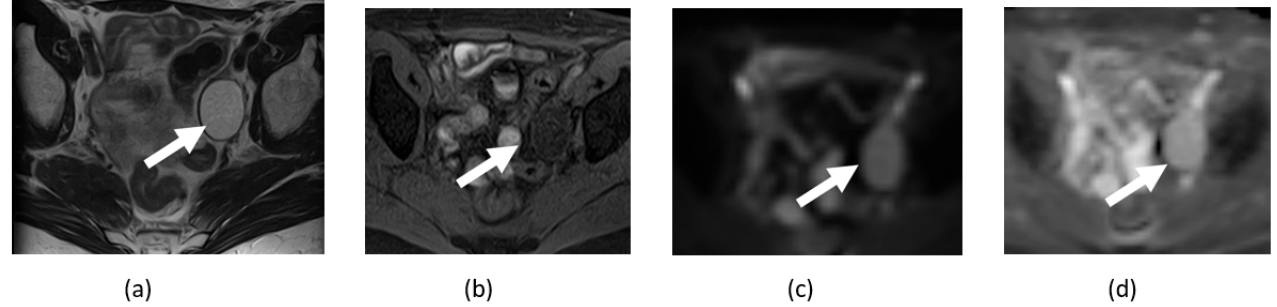
Figure 19. Axial T2-weighted image of the pelvis ( a ) showing hyperintense homogenous ovarian lesion (arrows) with low signal on T1-weighted image with fat suppression ( b ). The lesion shows high signal on low b value DWI ( c ) without the corresponding low signal on ADC map ( d ), suggesting a phenomenon known as “T2 shine-through”.